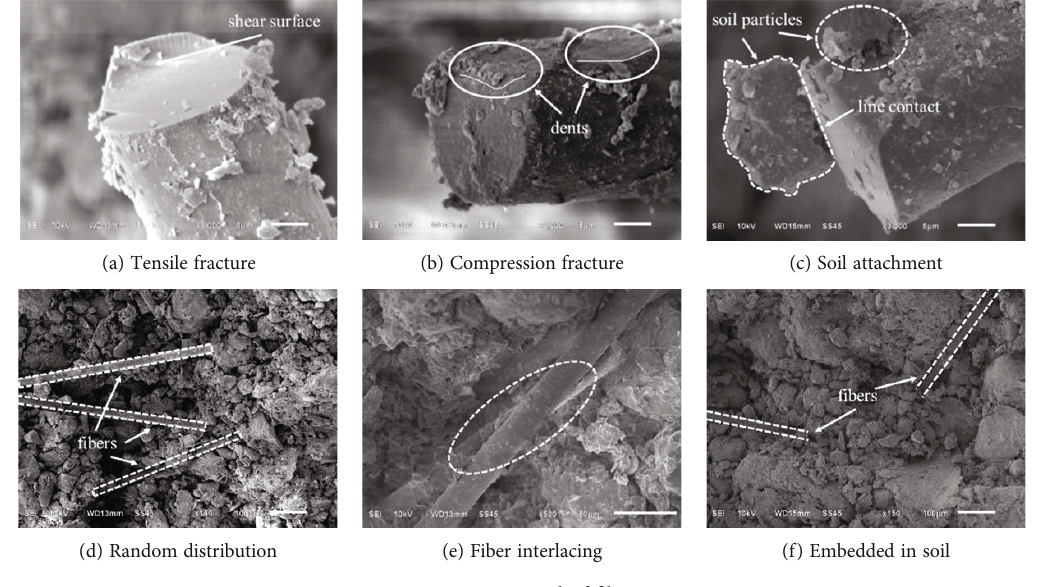
Figure 10: Detail of fi ber.